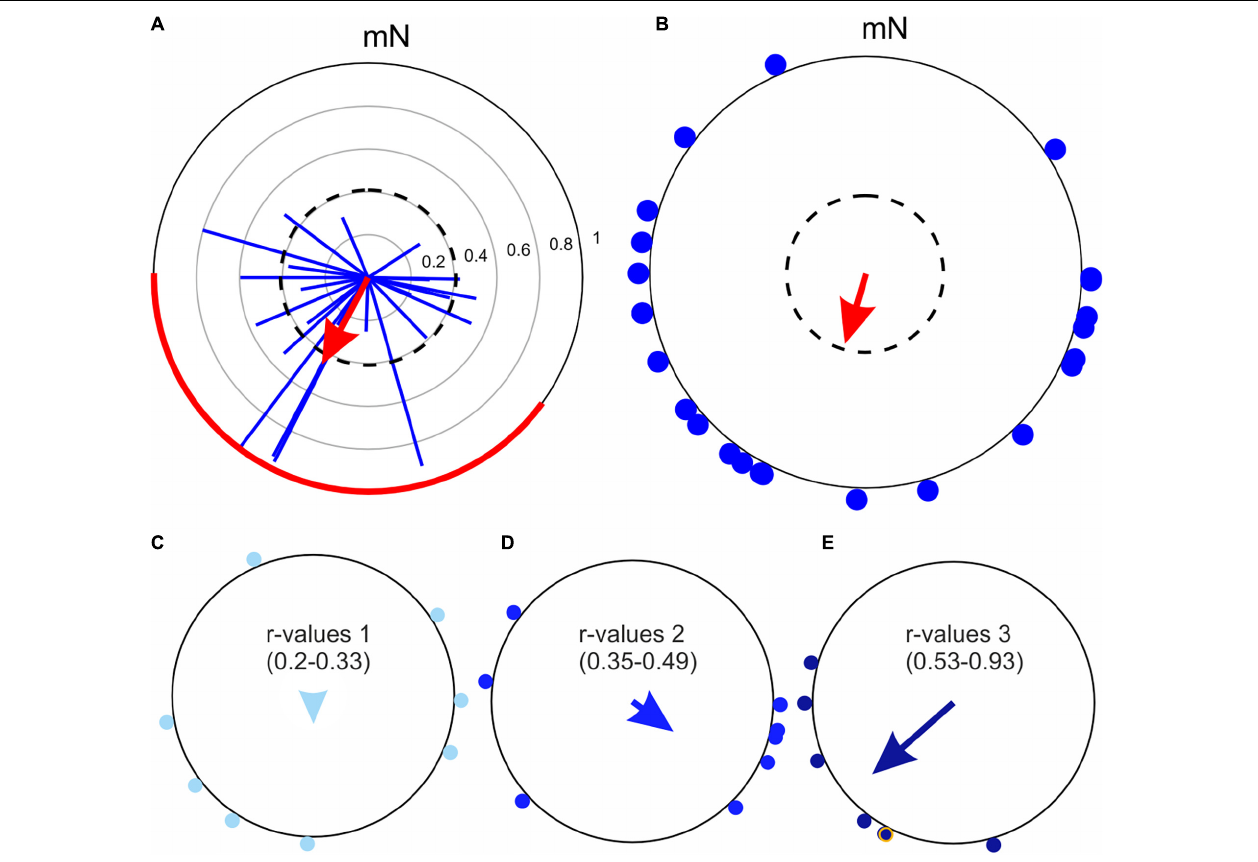
FIGURE 8 | A comparison of the non-parametric Moore’s modified Rayleigh test (MMRT) and the classical Rayleigh test, using the flight trajectories of 23 Dark sword-grass moths ( Agrotis ipsilon ) recorded at Col de Coux in Switzerland. (A) Flight trajectories analyzed using the MMRT. The individual flight trajectory vectors of each moth are shown as blue vectors and the average heading vector of the population (sample) derived from the test is shown as the red arrow . The dashed circle indicates the required R * value for statistical significance ( p < 0.05) and the red line on the outer circle marks the 95% confidence interval. The thin gray circles indicate the r value (in steps of 0.2), which are applicable to the flight trajectory vectors of individual moths ( blue vectors ). (B) Same data as in A, but now evaluated using the classic Rayleigh test. The mean flight directions of each moth are shown as blue dots around the periphery of the circle. According to the classic Rayleigh test, which does not weight the orientation choices according to their r value (as does the Moore’s modified Rayleigh test, A), the population is not significantly oriented. The dashed circle indicates the required α -level for statistical significance ( p < 0.05). Note that the length of the red arrow in B encodes the r value, not the R* value. (C–E) The mean flight directions of individual moths (from panel B ) were ranked according to the lengths ( r values) of their underlying flight trajectory vectors (from panel A ) and accordingly assigned to three bins: r values 0.20–0.33 ( C , n = 8), r values 0.35–0.49 ( D , n = 8), and r values 0.53-0.93 ( E , n = 7). The mean vectors for each of the three sub-populations were computed using only the mean flight directions of the moths ( arrows in each plot). Moths with flight trajectory vectors having larger r values (C) tend to cluster more tightly around a single orientation direction (leading to a longer mean sub-population